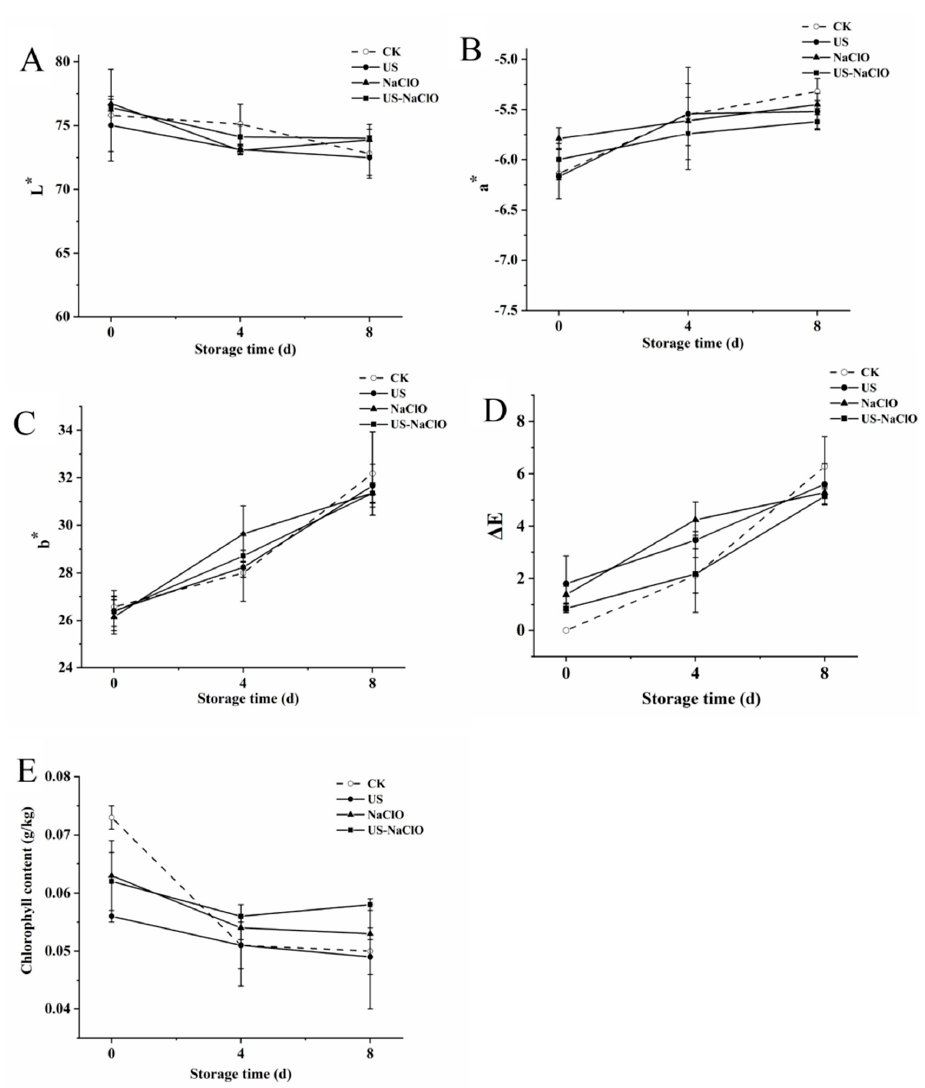
Figure 4. Effects of US, NaClO and US-NaClO treatments on L* ( A ), a* ( B ), b* ( C ), ∆ E ( D ) and chlorophyll content ( E ) of fresh-cut cucumber during storage.